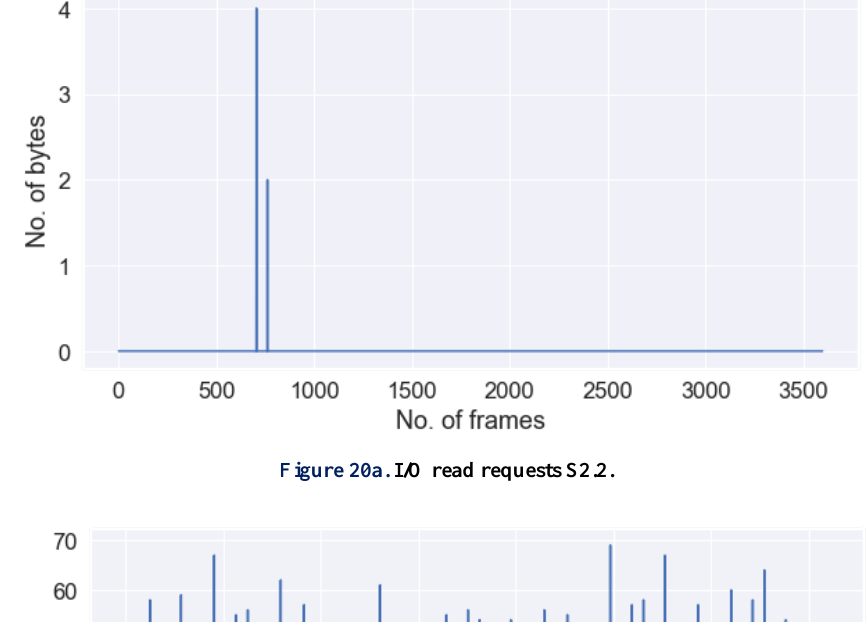
Figure 20a. I/O read requests S2.2.